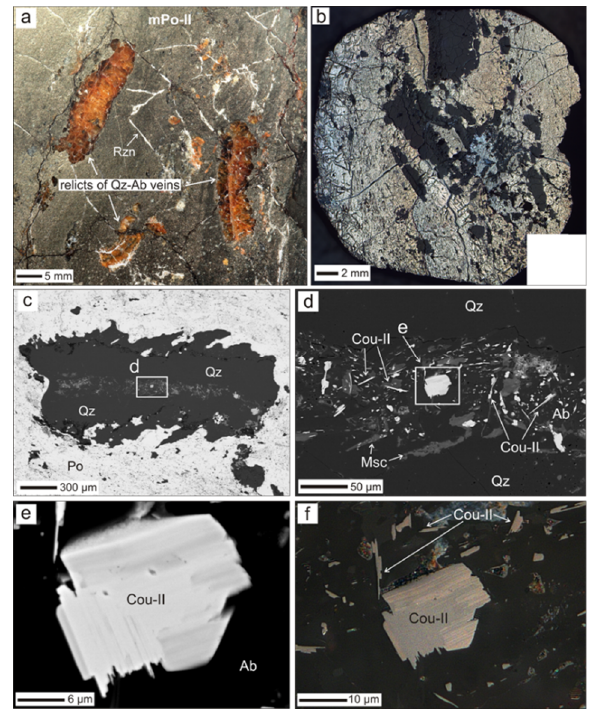
Figure 4. Coulsonite-II (Cou-II) in relics of quartz–albite (Qz-Ab) veins: ( a )—relics of Qz-Ab veins in the sample of massive pyrrhotite ores of type II (mPo-II) (Rzn—rozenite); ( b – d )—relics of Qz-Ab veins (dark grey) in a polished section of mPo-II (reflected light images); ( e , f )—Cou-II in the BSE image ( e ) and reflected light images ( f ). Msc—muscovite. BSE—back-scattering electron.